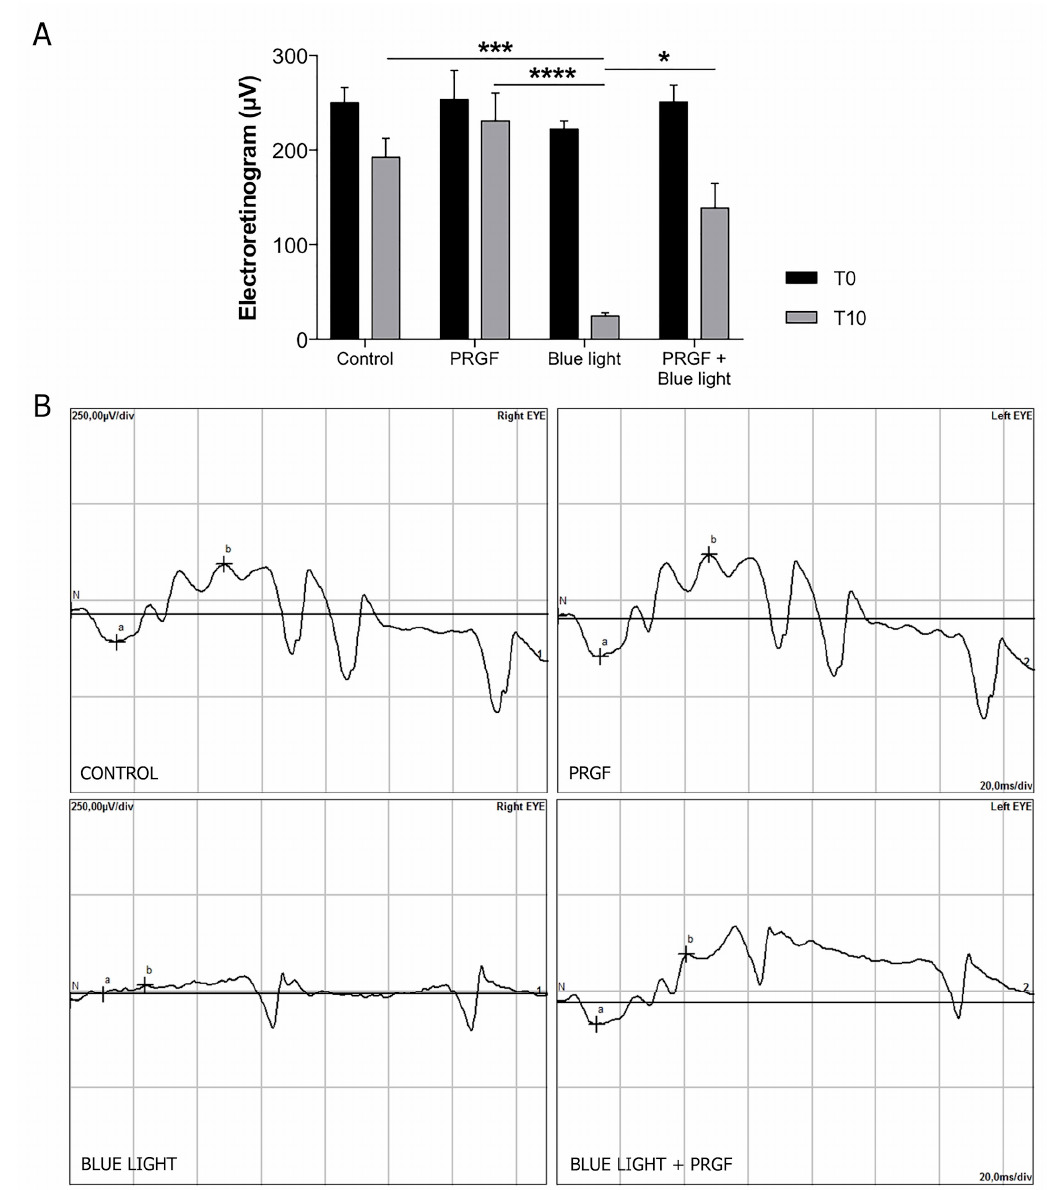
Figure 1. ( A ) Graphical representation of wave b measurements obtained from electroretinography (ERG) in scotopic 3.0 conditions at time 0 and time 10 ( n = 4). T10 results showed that blue light reduced significantly the electrical signal produced by rat retinas compared to control. However, plasma rich in growth factors (PRGF) combined with blue light recovered the signaling pattern. We also found significant differences in the interaction between time and treatment ( p = 0.036). Simple statistical analysis for time showed significant differences ( p < 0.0001) probably produced by the experimental procedure. The treatment parameter also showed significant differences ( p = 0.0001), indicating that blue light reduced the electrical signal and PRGF recovered it. Statistical analysis: Two-way ANOVA, Tukey’s multiple comparison test; * p < 0.05, *** p < 0.0005, **** p < 0.0001. ( B ) ERG diagram at time 10. Control and PRGF-treated retinas showed a normal electrical signal. Retinas treated with blue light showed a disruption of the electrical signal, which was recovered close to control values when blue light was combined with PRGF.